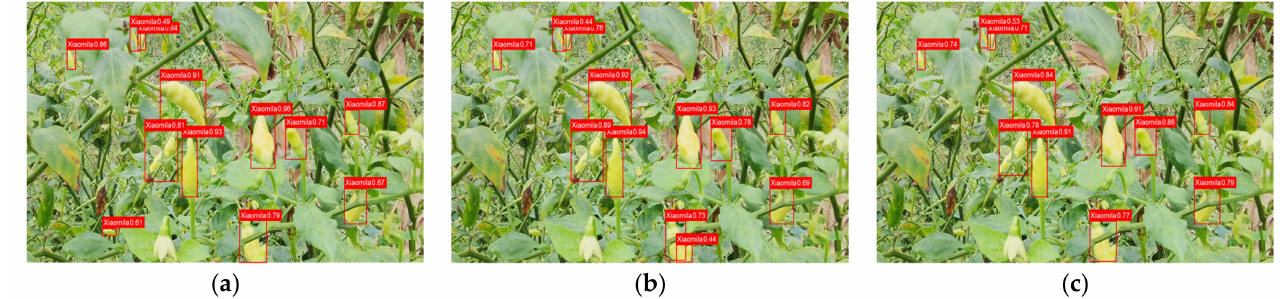
Figure 12. Comparison of the detection results of different models in the afternoon with YOLOv5s- CFL, YOLOv5s, and YOLOv3-tiny respectively. ( a ) YOLOv5s-CFL. ( b ) YOLOv5s. ( c ) YOLOv3-tiny.